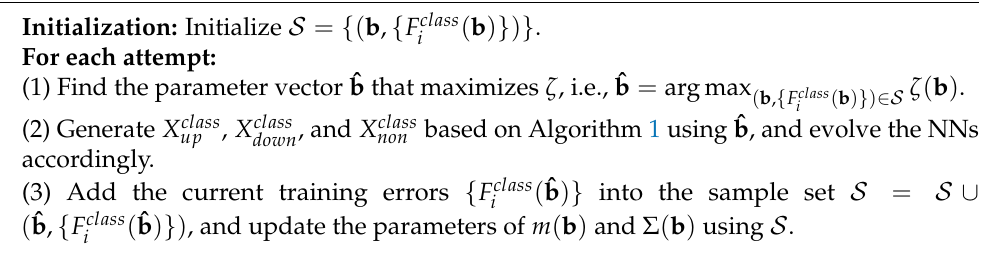
Algorithm 2 Bayesian optimization-based parameter